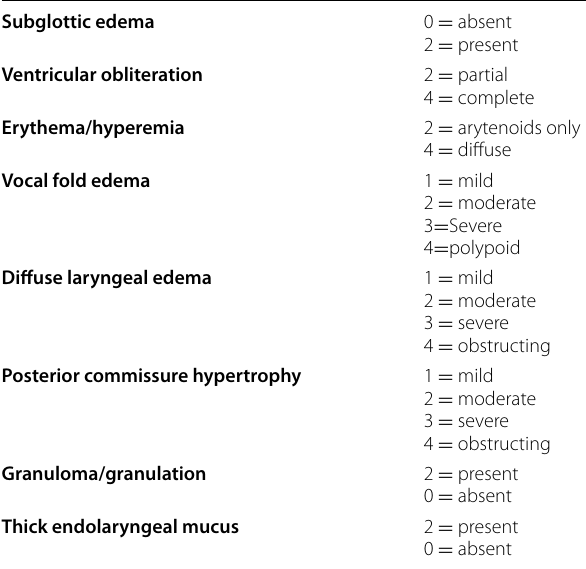
Table 1 Belafsky reflux finding score